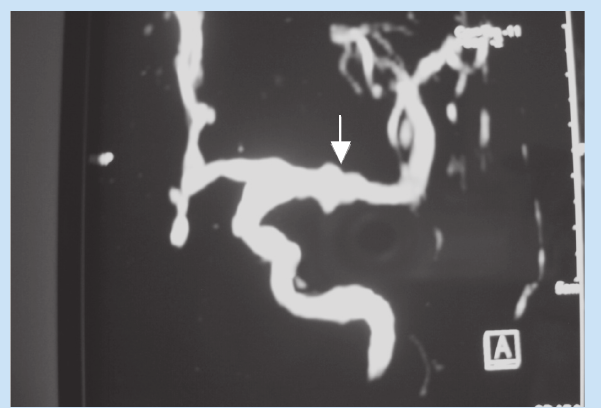
Fig. 5. Magnetic resonance angiogram (MRA) showing vascular irregular- ity with alternating areas of stenosis and dilatation of the middle cerebral artery (arrow).